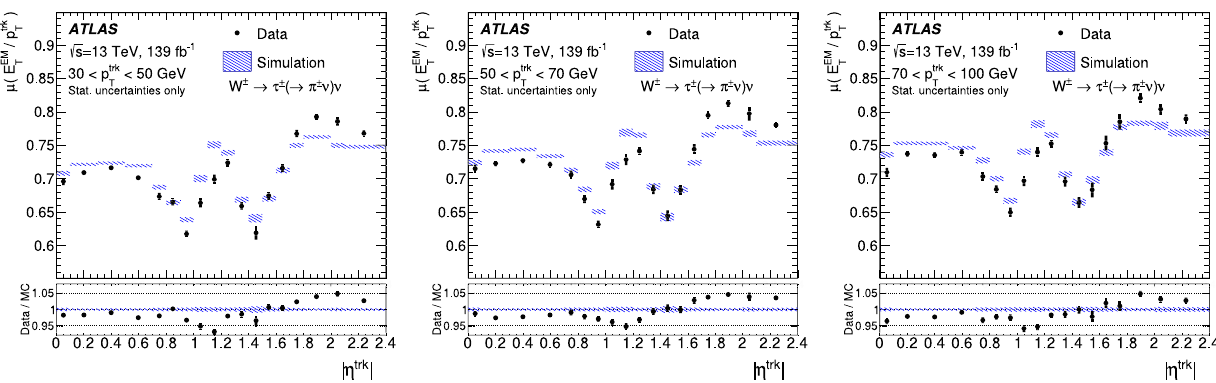
/ p trk distribution as a function of the track | η trk | in three different p trk T T